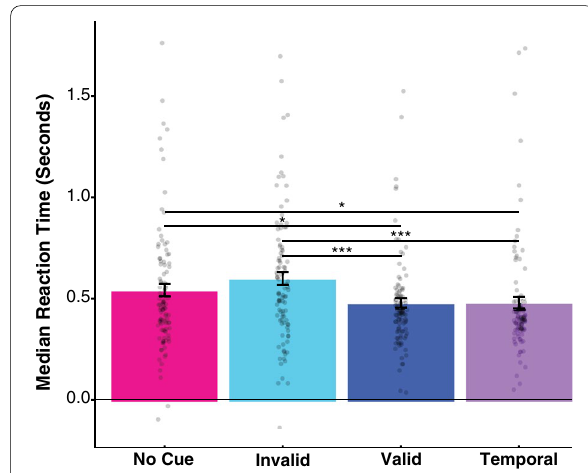
Fig. 3 Reaction time results. Each individual dot represents one participant’s median reaction time for that condition, and bars represent the group mean within the corresponding condition. Mean reaction time in the absence of a cue was 542 ms (magenta bar); invalid spatiotemporal cue (cyan bar) was 600 ms ( cue), valid spatiotemporal cue (navy bar) was 479 ms ( temporal cue only (violet bar) was 481 ms ( represents p values < 0.05; three asterisks represent p values < .0001. Error bars are standard error of the